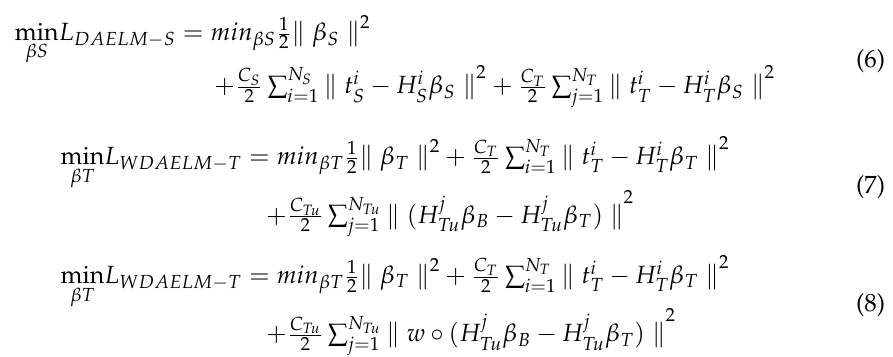
Figure 12. Validation result for different drift compensation methods [35].